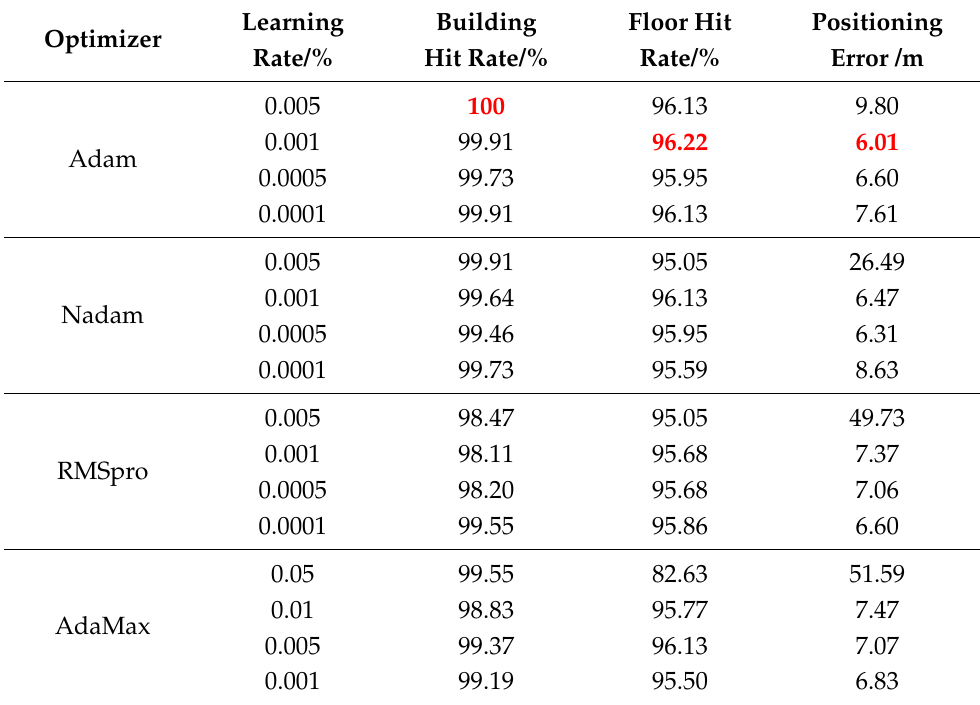
Table 2. Positioning performance of different learning rates in multi-building, multi-floor, and location estimation.